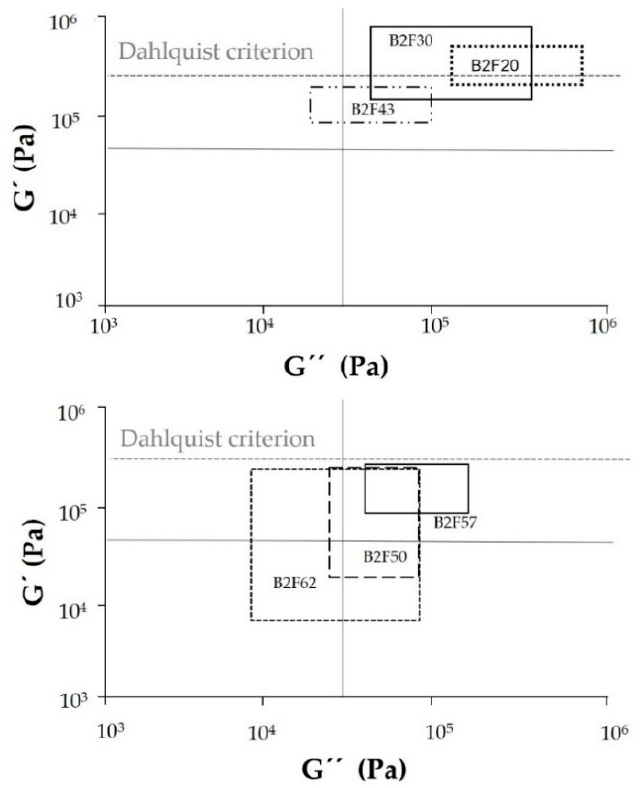
Figure 10. Chang’s viscoelastic windows for EBA copolymer + ECH resin blends.